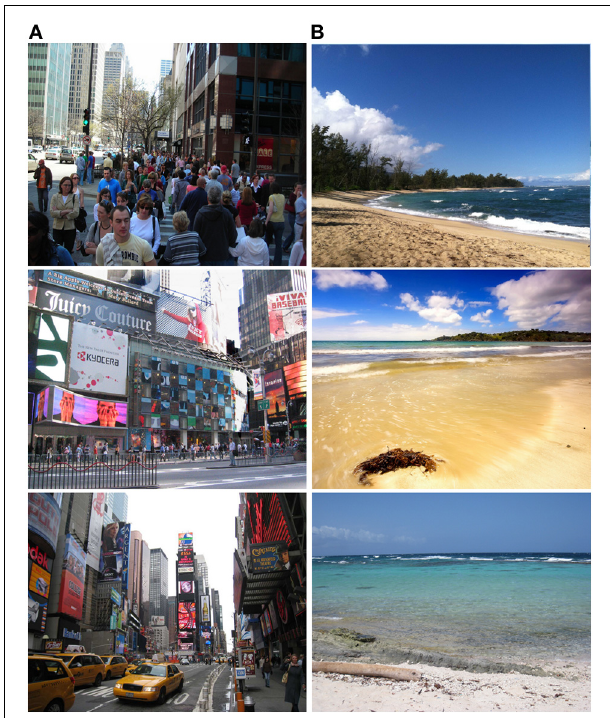
FIGURE 1 | Sample images from the experiment. (A) Images are from the urban set, while (B) are from the nature